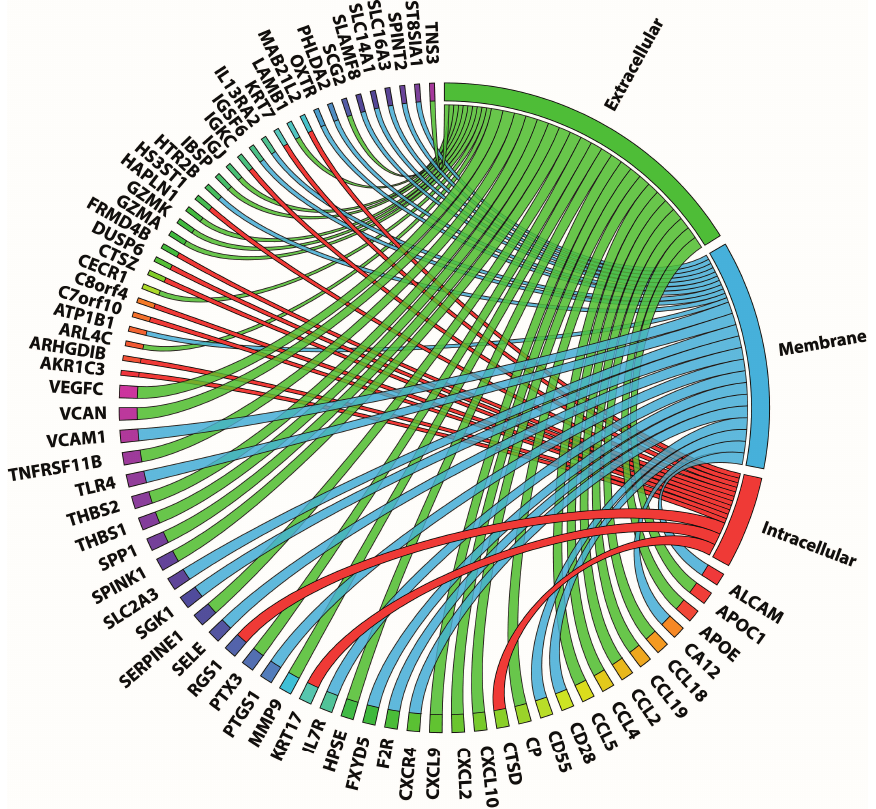
Figure 1. Localization of products of genes expressed in both plaque types. Gene products are organized according to their localization: extracellular (green), cell membrane (blue), and intracellular (red). Wider ribbons represent a known link to atherosclerosis, as determined by literature mining (see Methods).